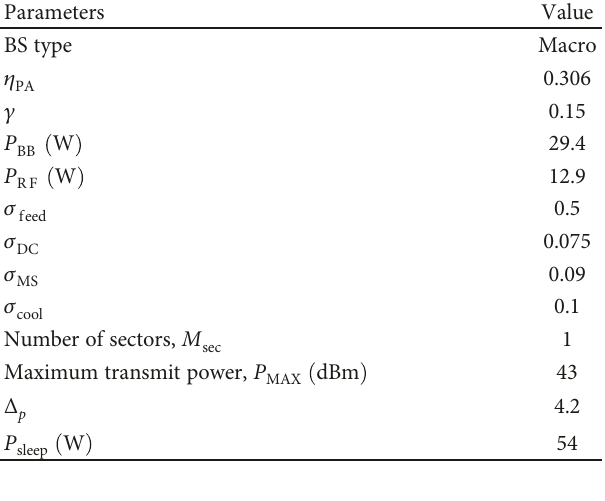
Table 2: BS power consumption model parameters